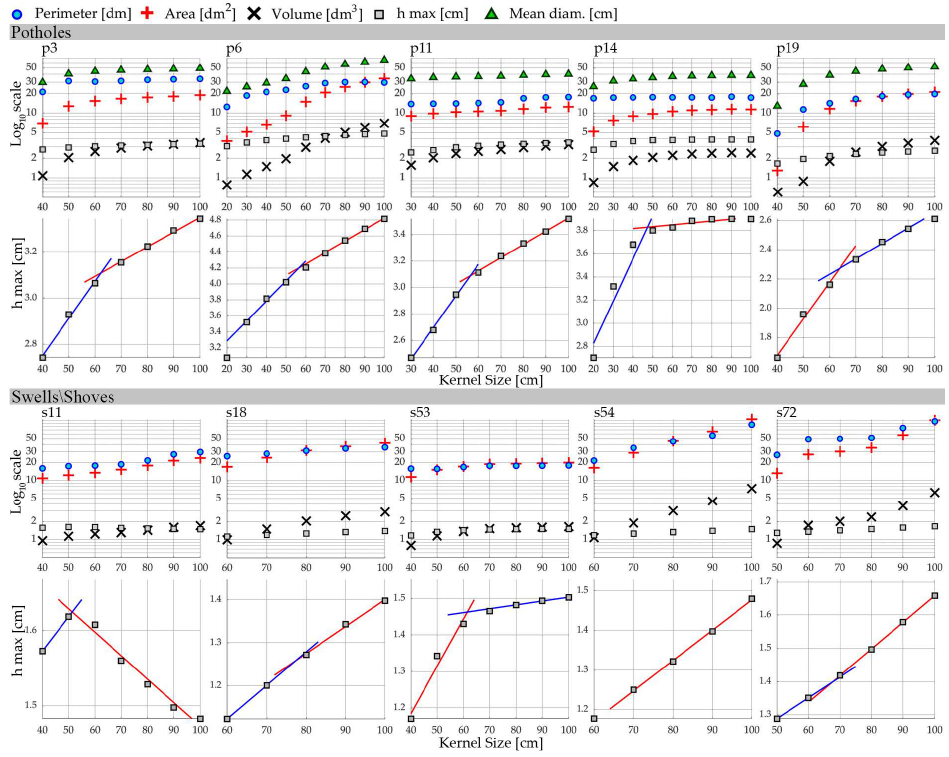
Figure 17. Trend of the main geometrical parameters of a few distresses as the kernel size changes.